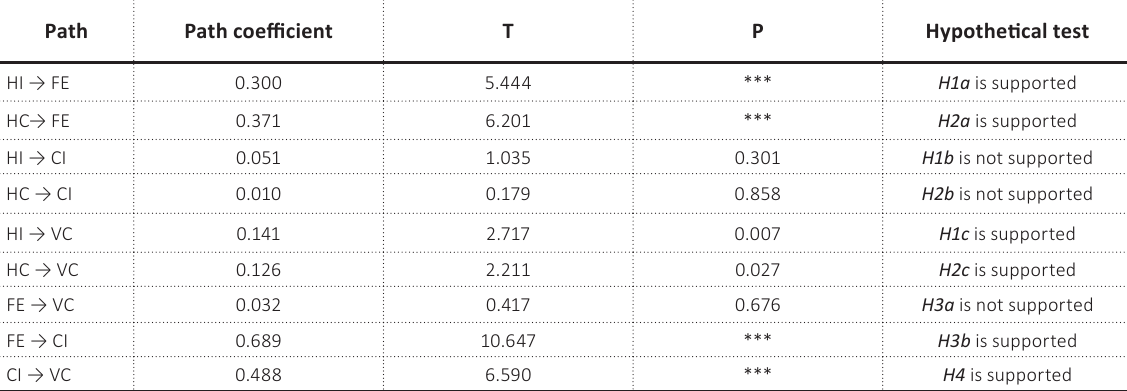
Table 4. Path analysis results